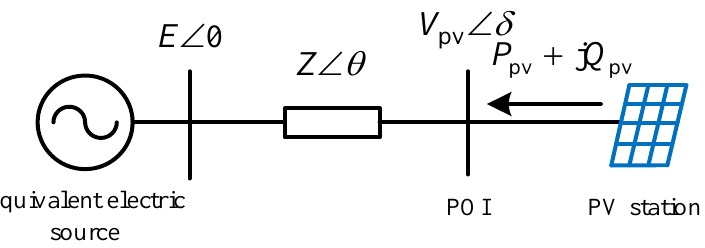
Figure 1. The simplified PV grid-connected two-node system.